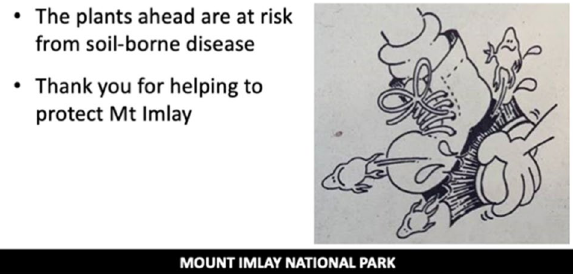
Figure 7. Hygiene sign from a track in Mount Imlay National Park, NSW, shown to volunteers prior to boot brushing in the current study.